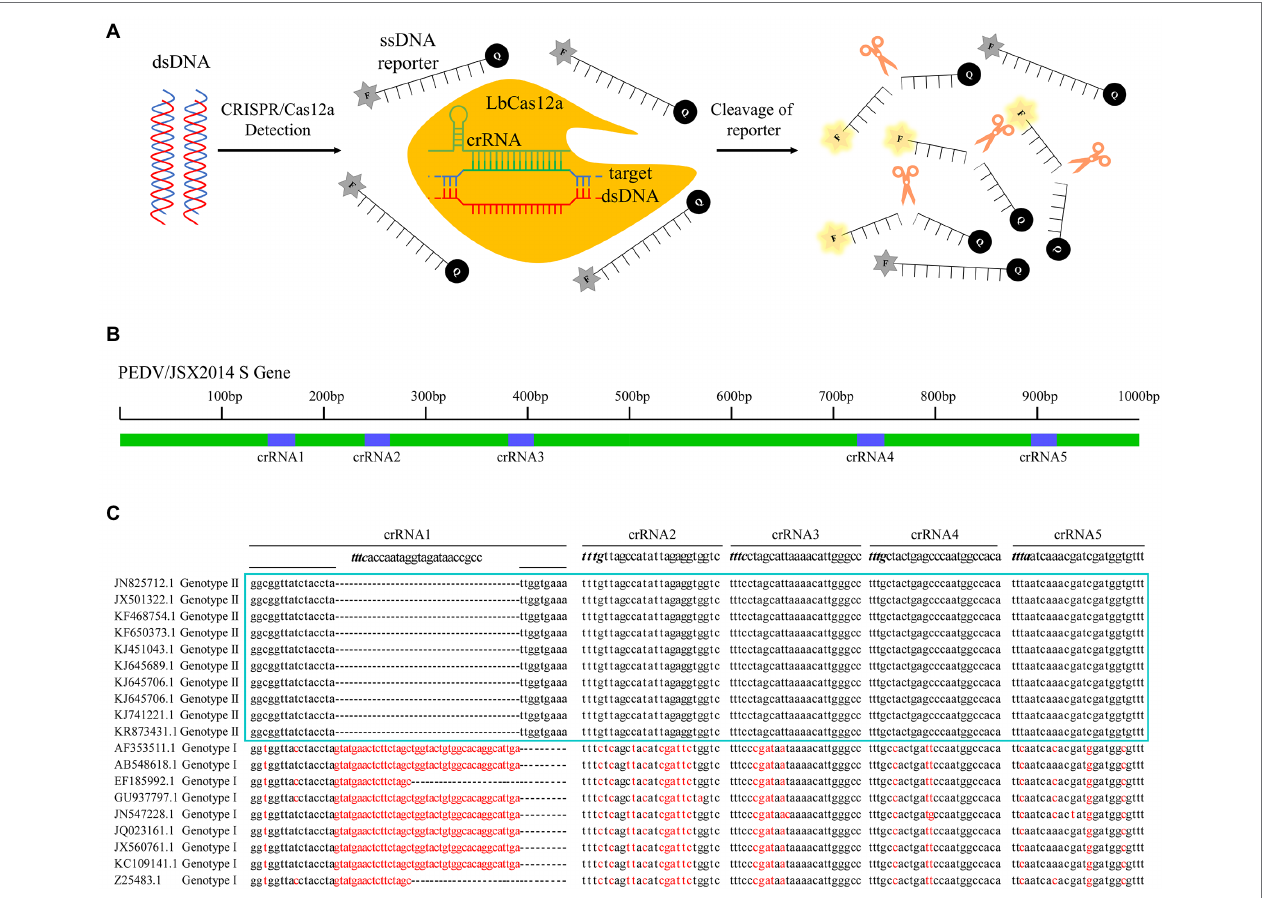
FIGURE 2 | Design of clustered regularly interspaced short palindromic repeat (CRISPR) RNA (crRNA) of porcine epidemic diarrhoea virus (PEDV) Spike gene and schematic diagram of CRISPR/Cas12a-fluorescent detection system (FDS). (A) Schematic diagram of the CRISPR/Cas12a-FDS assay. Specific crRNAs targeting the PEDV Spike gene were designed for PEDV genome detection. When CRISPR/Cas12a proteins were bound to double-stranded DNA (dsDNA) guided by specific crRNA, it nonspecifically activated its trans-cleavage activity, the quenched fluorescent ssDNA was cleaved and thus stimulating fluorescence. F, fluorophore; Q, quencher. (B) Five crRNAs targeting Spike gene selected for PEDV detection and the relative positions of these crRNAs in S gene. (C) Sequence alignment of Spike genes from 19 strains of PEDV targeted by crRNAs. The nucleotide variants from the consensus sequence were highlighted with red